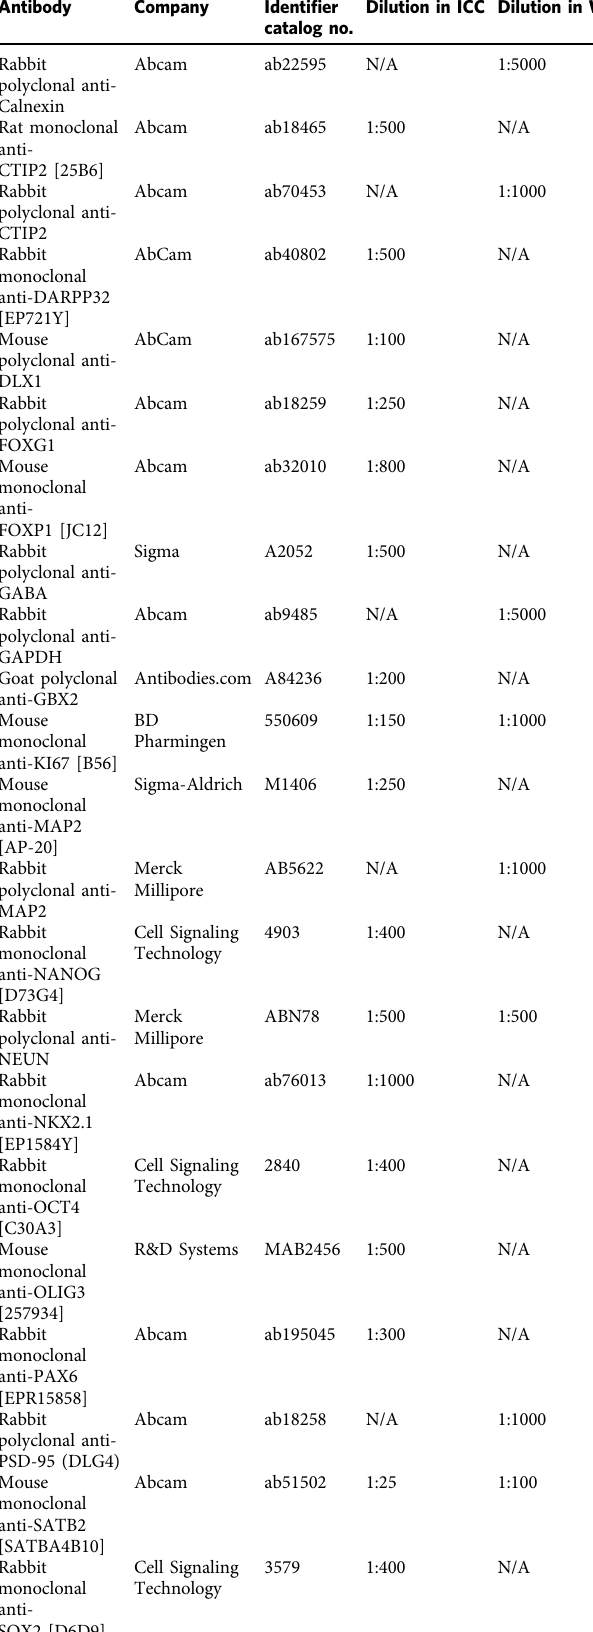
on a roller mixer, the resin was washed 5 times with ice cold DOC buffer and the bound protein eluted by 15 min 70 °C incubation in 5% w/v sodium dodecyl sulfate (SDS, Sigma). The eluted protein was reduced with 10 mM TCEP and alkylated using 20 mM Iodoacetamide, trapped and washed on an S-trap micro spin column (ProtiFi, LLC) according to the manufacturer ’ s instructions and protein digested using trypsin sequence grade (Pierce) at 47 °C for 1h. Eluted peptides were dried in a vacuum concentrator and resuspended in 0.5% formic acid for MS